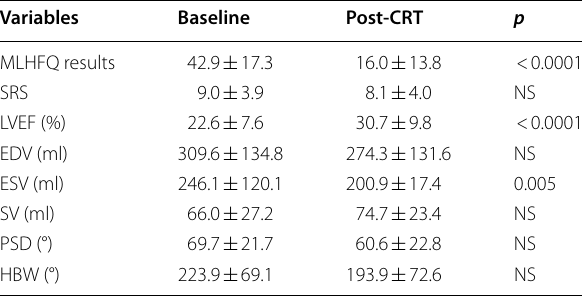
Variables are expressed as mean